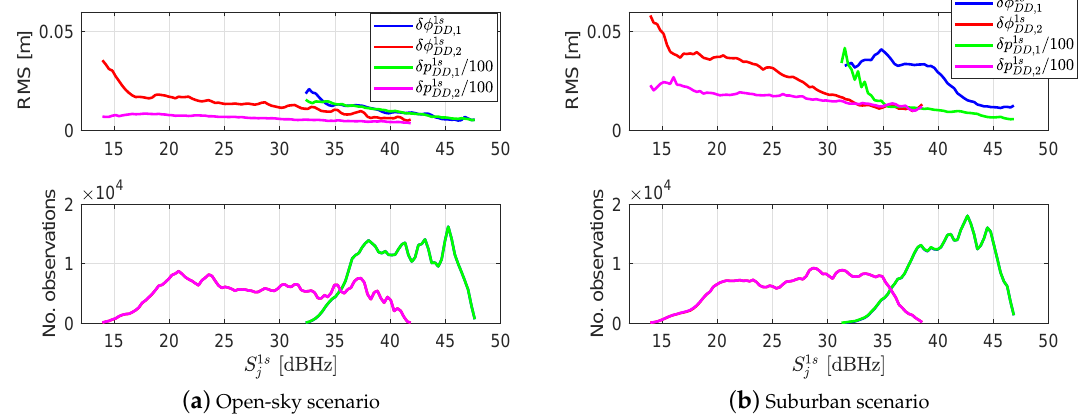
Figure 3. RMS of the DD residuals with respect to the C/N 0 ( S 1 s ( b ) the suburban scenario. Note that the RMS of the code residuals is divided by a factor of 100. In the bottom panels, the blue and the red lines are almost overwritten by the green and the magenta